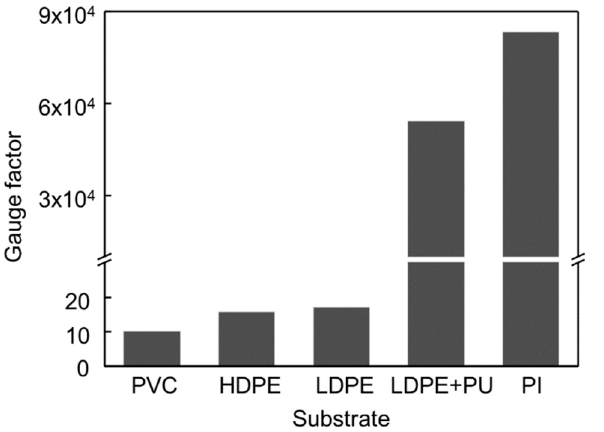
Figure 3. Comparison of gauge factor of crack-based strain sensors with different substrates.